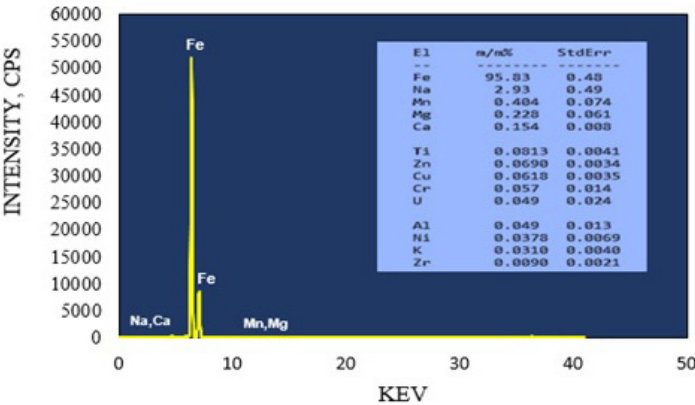
Figure 9. The X-Ray spectrum analysis of the elemental composition of the iron powder produced after reduction at 900 o C.